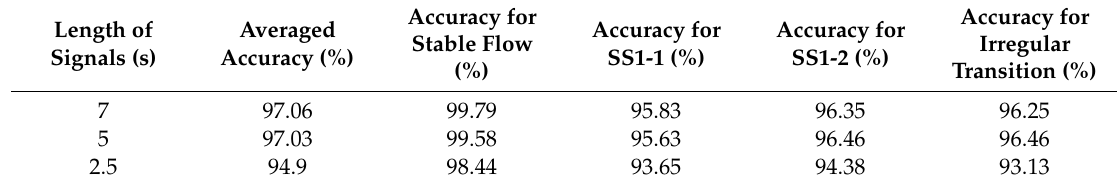
Table 6. Multiclass classification results of the NN with six